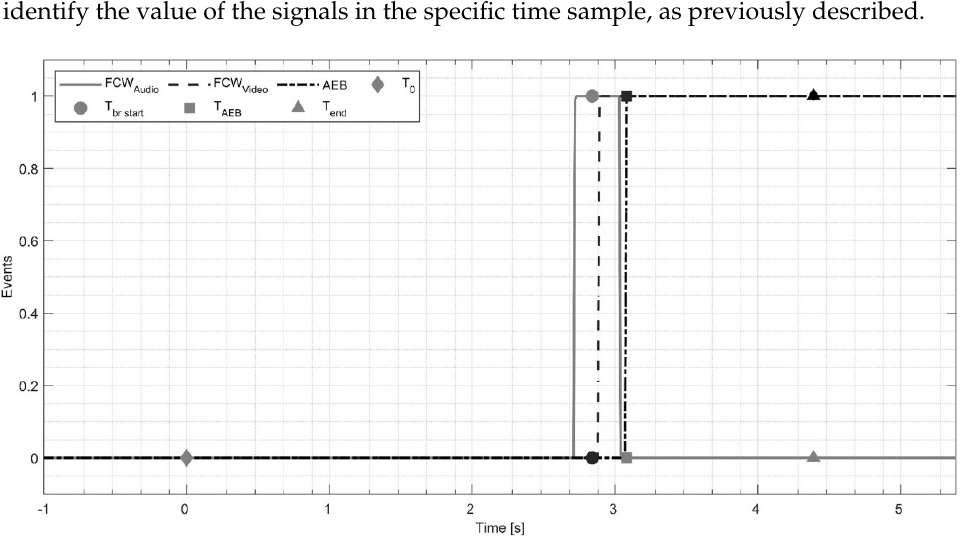
Figure 23. Trigger FCWs and AEBs signals.